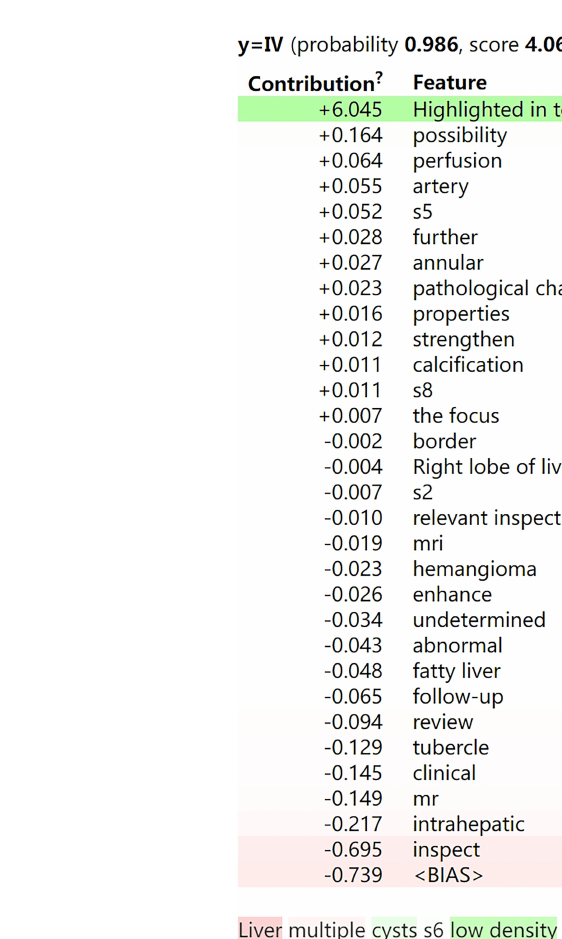
FIGURE 6 The classi fi cation result of an example of CT with/without contrast report. “ y ” was assigned to a certain category according to the probability, with green representing features that were positively related to this category, and the darker the green the greater the degree of correlation. Red represented features that were negatively related to this category, and the darker the red the less relevant they were. For publication purposes, we provided English version of Chinese words from the imaging